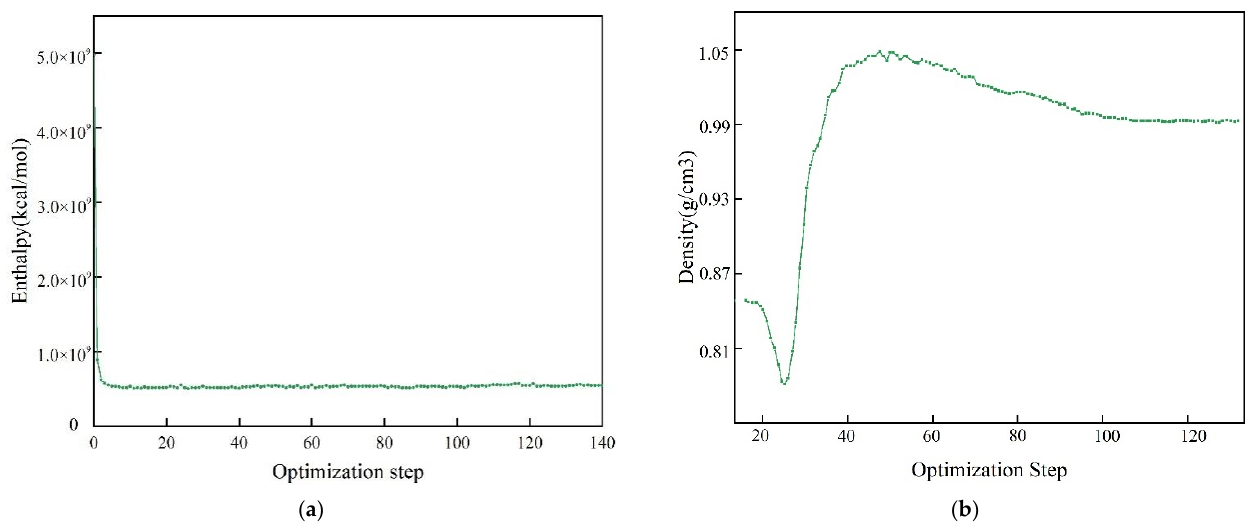
Figure 2. Reliability assessment of energy and density results obtained from molecular simulations: ( a ) energy curves, and, ( b ) density curves.